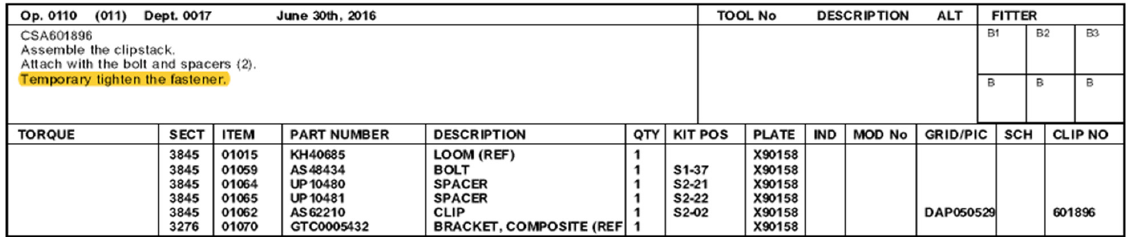
Figure 4. The SOP process confirming hand tightening of screws.